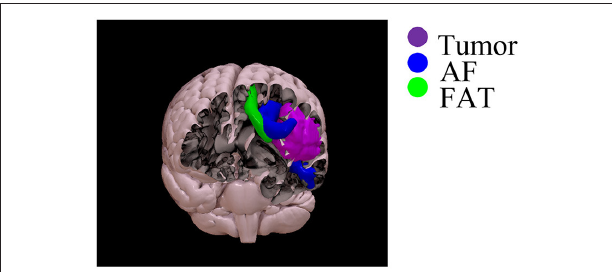
FIGURE 1 | Three-dimensional rendering of the reconstruction of the AF (blue), FAT (green), and tumor segmentation (violet) in the same patient with left frontal glioblastoma grade